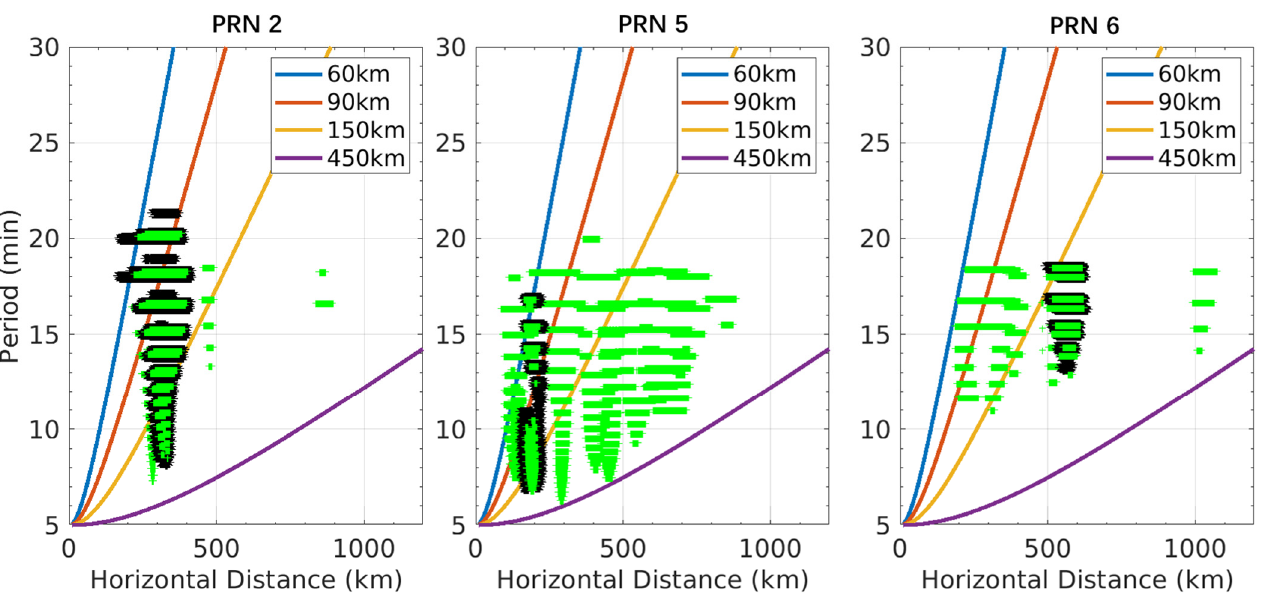
Figure 8. Horizontal propagation distance versus GW period: comparison of theoretical and measured values. The scatters represent the presence of GW, i.e., observations with energy greater than a certain threshold after the S-transformation. The black scatters show are observations from stations in Hongkong. The green scatters represent other stations. Four curves of different colors show the theoretical relationship between the period of the observable GW and the horizontal propagation distance at different heights in the ionosphere.